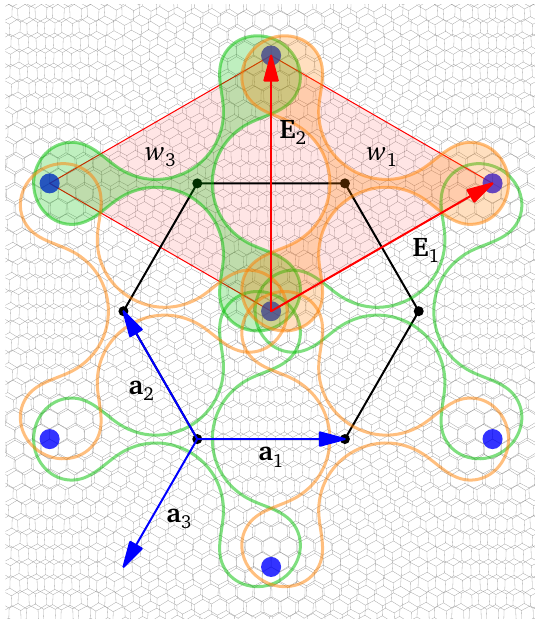
Figure 1: Schematic representation of the Wannier functions w w ∗ (orange) and 1 = 2 w w ∗ (green) on which our model Hamiltonian is built. The charge is maximal at 3 = 4 the AA superposition points (blue circles) forming a triangular lattice. The Wannier functions are centered on the triangular plaquettes that form a graphene-like lattice (black dots), whose unit cell is shaded in red. The underlying moiré pattern illus- trated corresponds to ( m , n ) = ( 9,8 ) , but the functions used in this work correspond to ( m , n ) = ( 26,25 ) . The basis vectors E of the moiré lattice are shown (they are 1,2 also basis vectors of the graphene-like lattice of Wannier functions), as well as the elementary nearest-neighbor vectors a 1,2,3